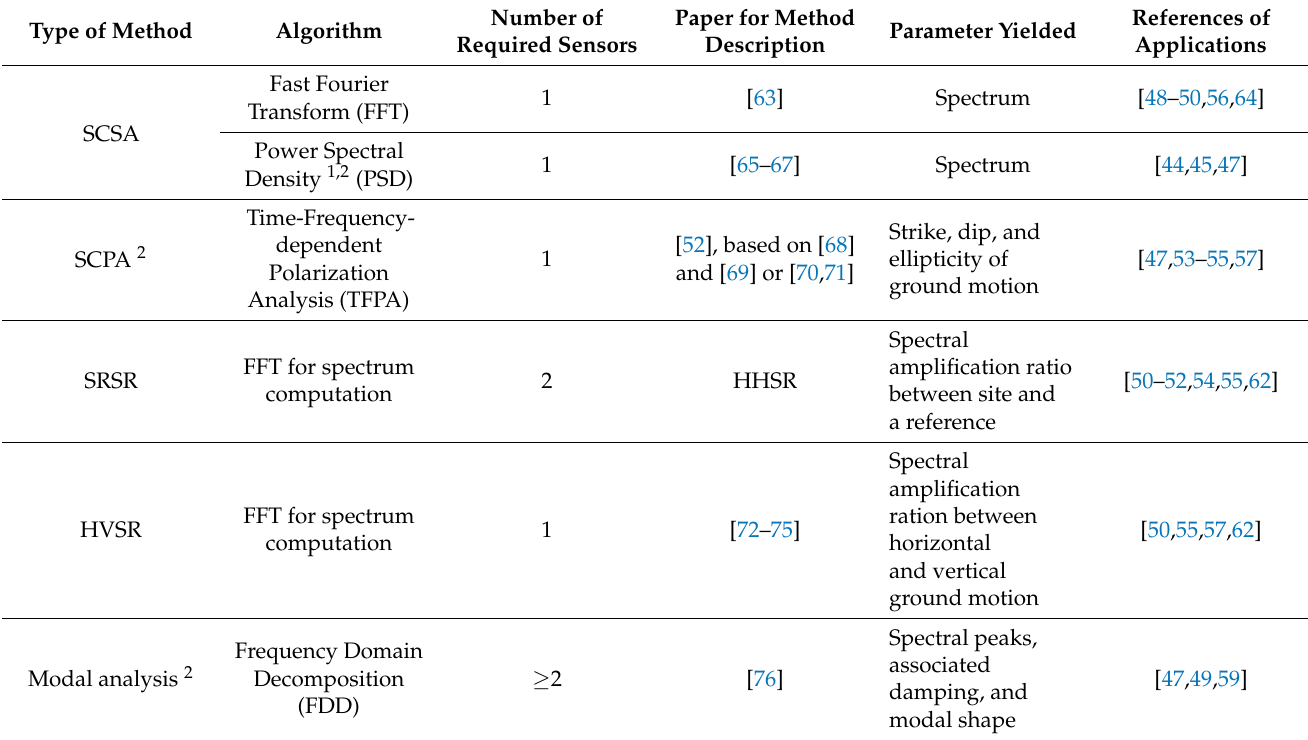
Table 1. Processing tools applied for ambient noise analyses on unstable